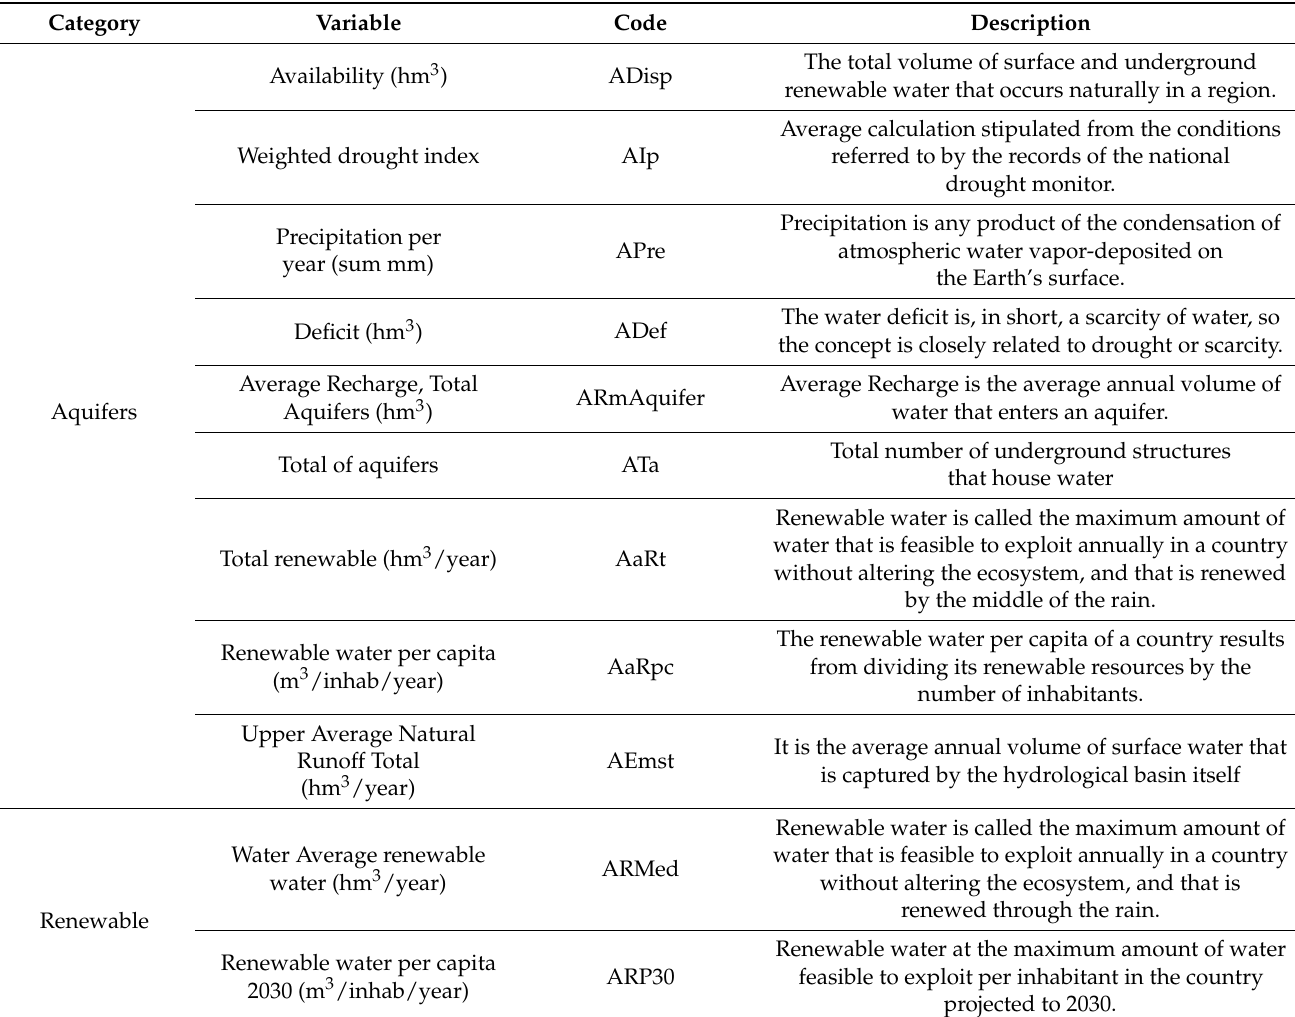
Table 1. Categorization, classification, and definition of the 26 variables extracted from the SINA platform.